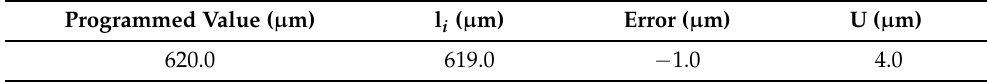
Table 1. Results of laser penetration